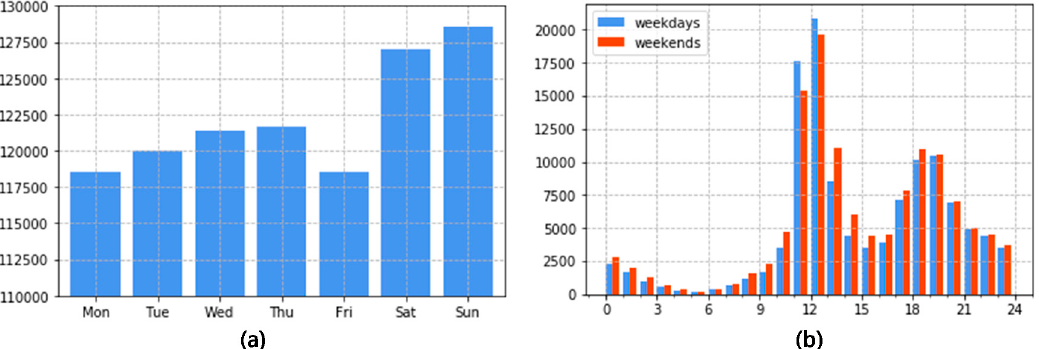
Figure 4. ( a ) Average number of delivery orders each day in a week; ( b ) Average number of delivery orders on an hourly basis on weekdays and weekends.